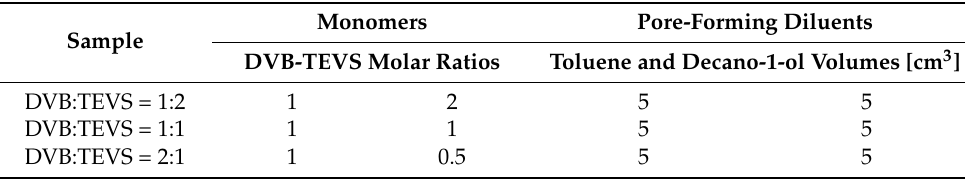
Table 8. Compositions of reaction mixtures in organic-inorganic materials synthesis. Monomers Pore-Forming Diluents Sample DVB-TEVS Molar Ratios Toluene and Decano-1-ol Volumes [cm 3